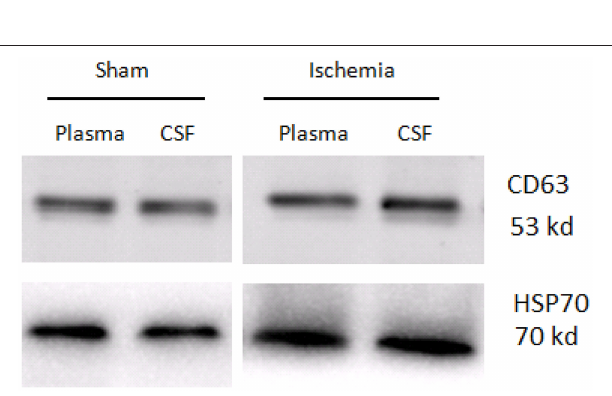
FIGURE 4 | The concentration and size distribution of plasma exosomes (A) and CSF exosomes (B) .